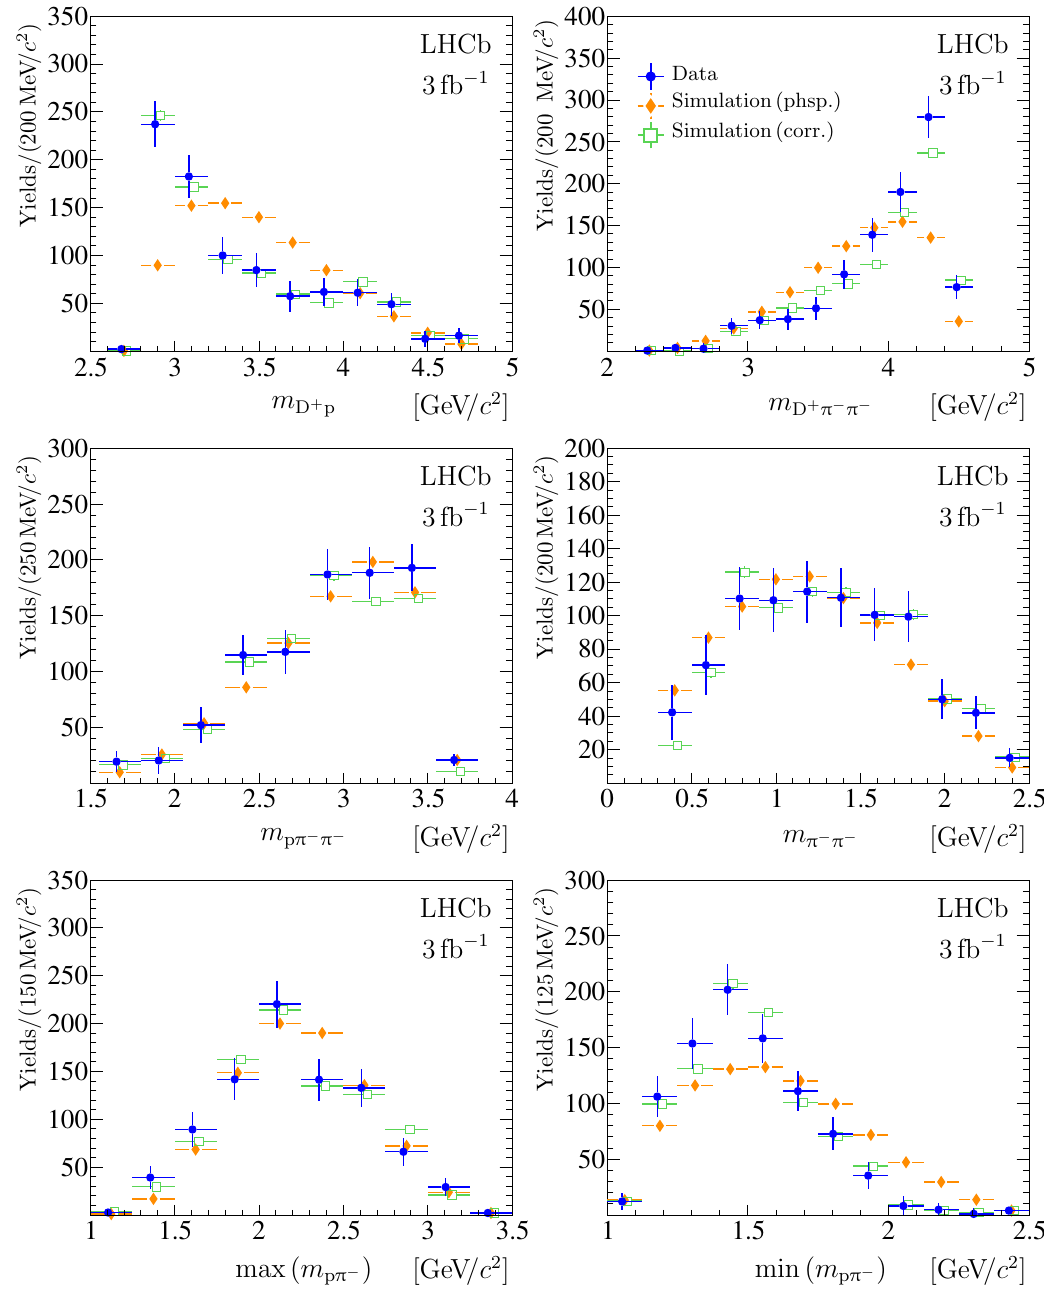
Figure 7 . Background-subtracted D + p , D + π − π − , pπ − π − , π − π − , and maximum and minimum pπ − mass spectra for Λ 0 → D ∗ + pπ − π − decays. Expectations from phase-space (phsp.) and cor- b rected (corr.) simulation are